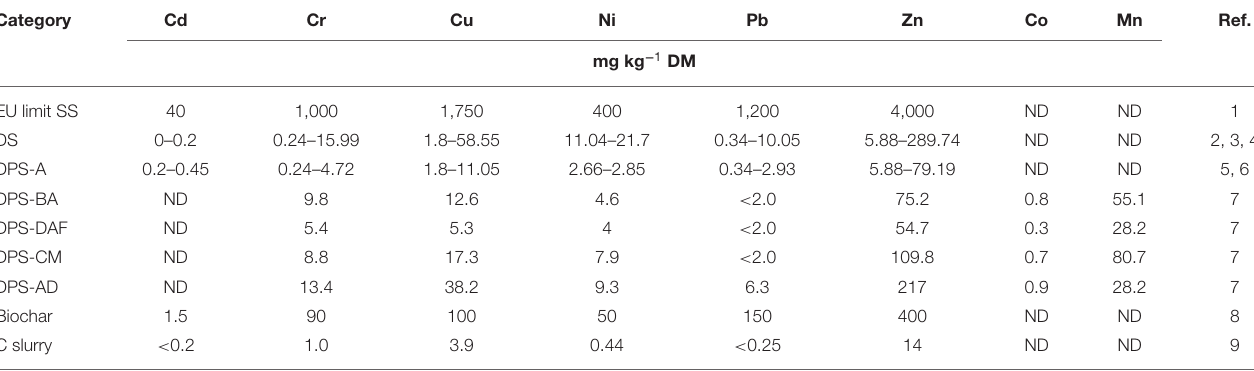
The values are collected from peer reviewed articles where data were given in as ranges, mean or median values [1: Directive 86/278/EEC (CEC, 1986); 2: López-Mosquera et al., 2000; 3: Yadav et al., 2009; 4: Frac et al., 2012; 5: Kumar et al., 2008; 6: Frac et al., 2017; 7: Ashekuzzaman et al., 2019a, 8: EBC, 2012; 9: Peyton et al., 2016)]. SS, Sewage sludge; DS, Different dairy sludge; DPS-A, Aerobic treatment; DPS-BA, Bio-chemically treated Activated sludge; DPS-DAF, Lime treated dissolved air floatation processing sludge; DPS-CM, Combined treated (using both AC and DAF process) sludge; DPS-AD, Anaerobically digested sludge; C slurry, Cattle slurry; ND, No data.